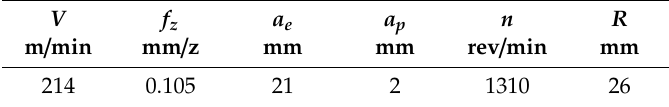
Table 2. Cutting parameters adopted in Sato et al. [35].